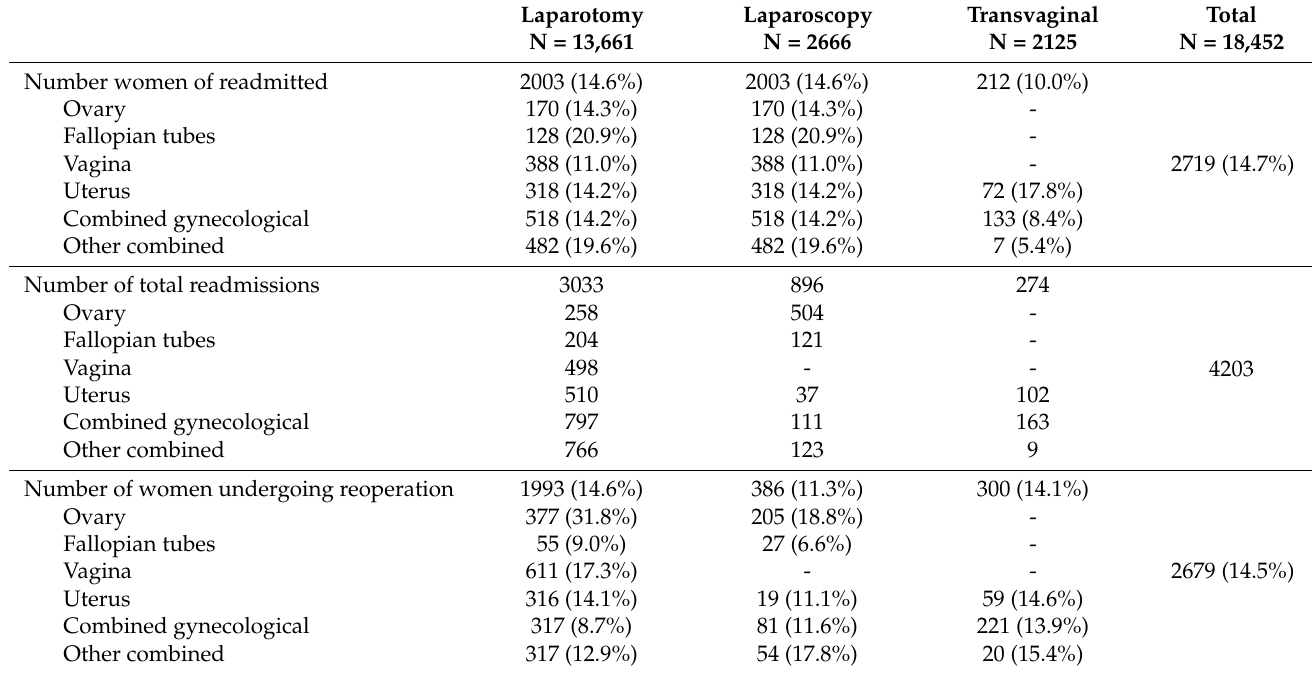
Table 1. Number of readmissions and reoperations.